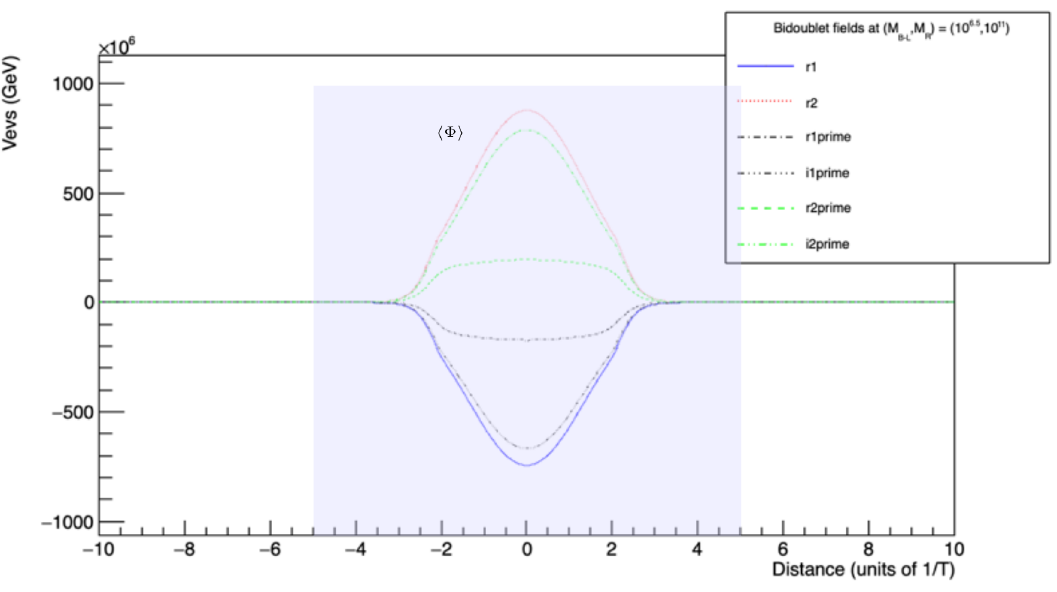
, i 0 , r 2 , r 0 , i 0 , as a function 1 1 2 2